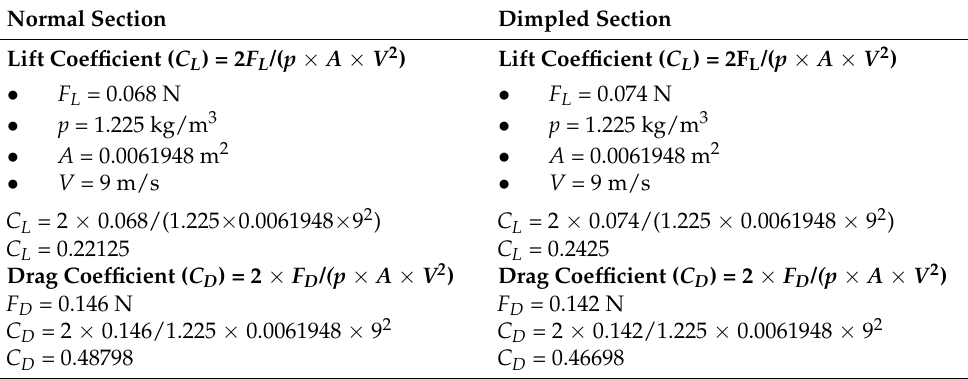
Table 2. CFD coefficients of both sections of the turbine blade at an optimum AOA for SRF. Normal Section